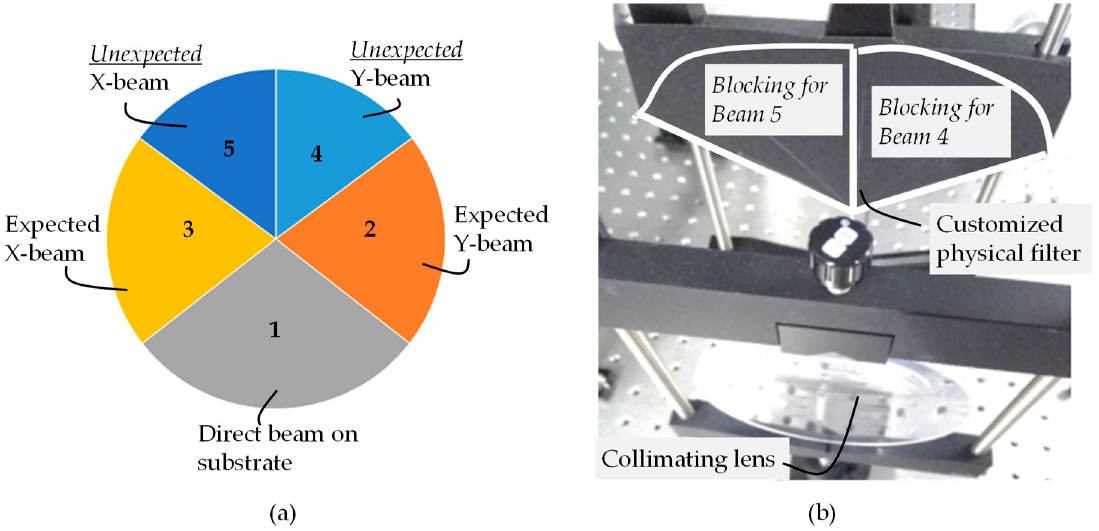
Figure 3. Optical configurations of orthogonal two-axis Lloyd’s mirror interferometer. ( a ) The sections of collimated beam (from the direction of the incident beam). ( b ) Improved physical filter.